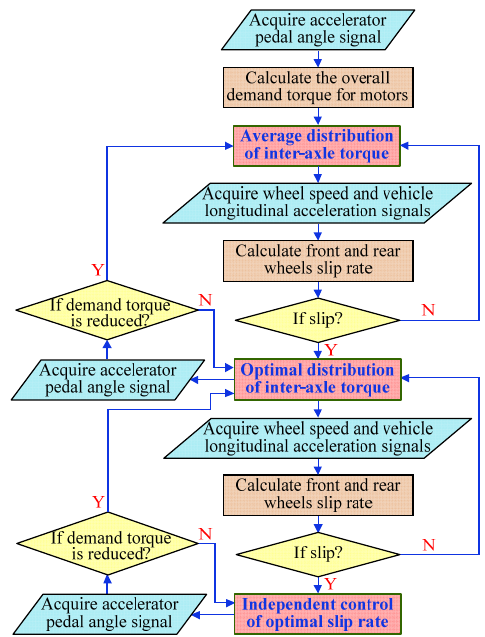
Figure 4. The acceleration slip regulation